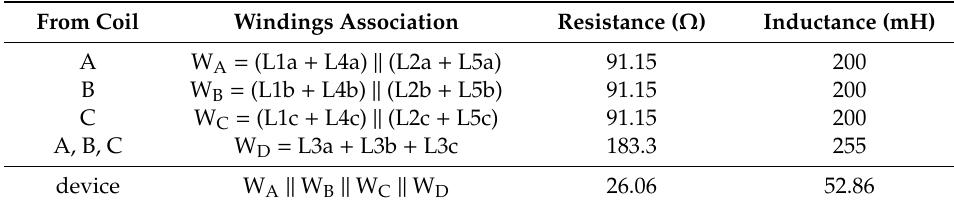
Table 2. Final Harvesting Device Parameters.